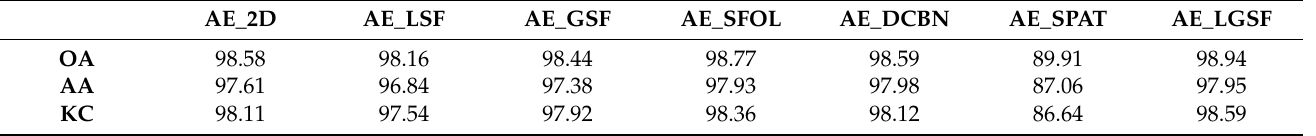
Table 12. Classification results of ablation experiments on the Pavia University dataset. (shown in %).